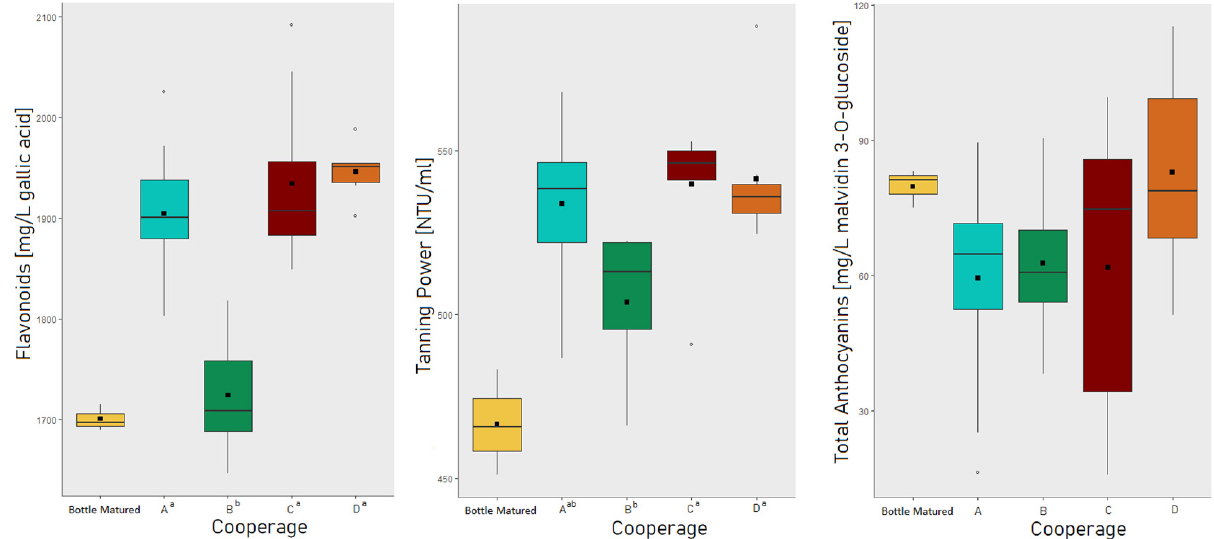
Figure 2. Boxplots of trial results for flavonoids, tanning power, and total anthocyanins with special separation for each cooperage and the bottle matured wine. For each parameter, cooperage codes followed by the same letter indicate not significantly different results at the 0.05 * level of significance.